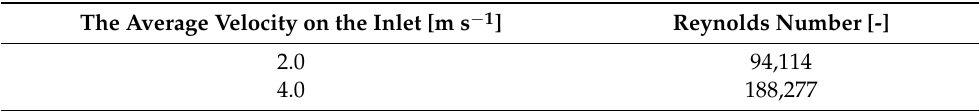
Table 10. Reynolds number values for different variants of calculation.